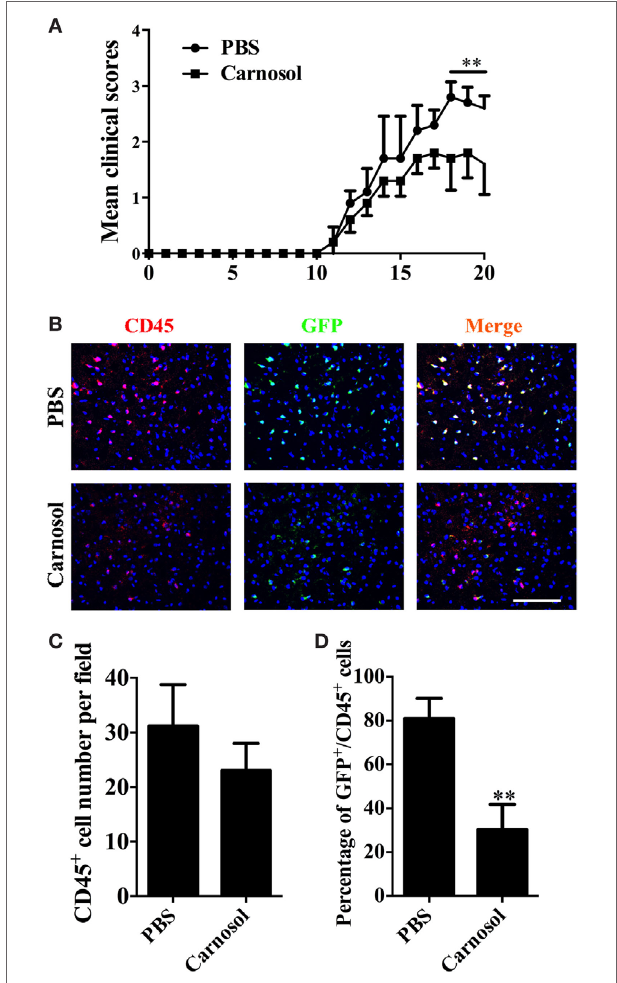
FigUre 5 | Carnosol decreased clinical severity in an adoptive transfer model of experimental autoimmune encephalomyelitis (EAE). For adoptive transfer EAE, single-cell suspensions were derived from spleen and lymph nodes of IL-17A-IRES-GFP EAE mice at day 10 p.i. MOG (25 µg/ml) plus IL-23 (10 ng/ml) and IL-2 (2 ng/ml) were added to cultures in the presence or absence of carnosol (10 µM) for 3 days. 1 × 10 6 CD4 T cells were i.v. injected to the recipient mice. (a) Mean clinical score of adoptive transfer EAE (mean ± SD; n = 5 each group). ** p < 0.01, Two-way ANOVA with Sidak test. (B) Mice were sacrificed at day 20 after cell transfer, and brains were subjected to immunostaining analysis of CD45 + and GFP + cells (marker for Th17 cells). Statistical analyses of total CD45 + cell numbers (c) and the percentage of GFP + CD45 + cell (D) for staining in (B) are shown. Scale bar = 100 µm. Symbols represent mean ± SD ( n = 5 each group) ** p < 0.01, determined by two-way ANOVA (a) , or nonparametric test (c,D) . One representative of two independent experiments is